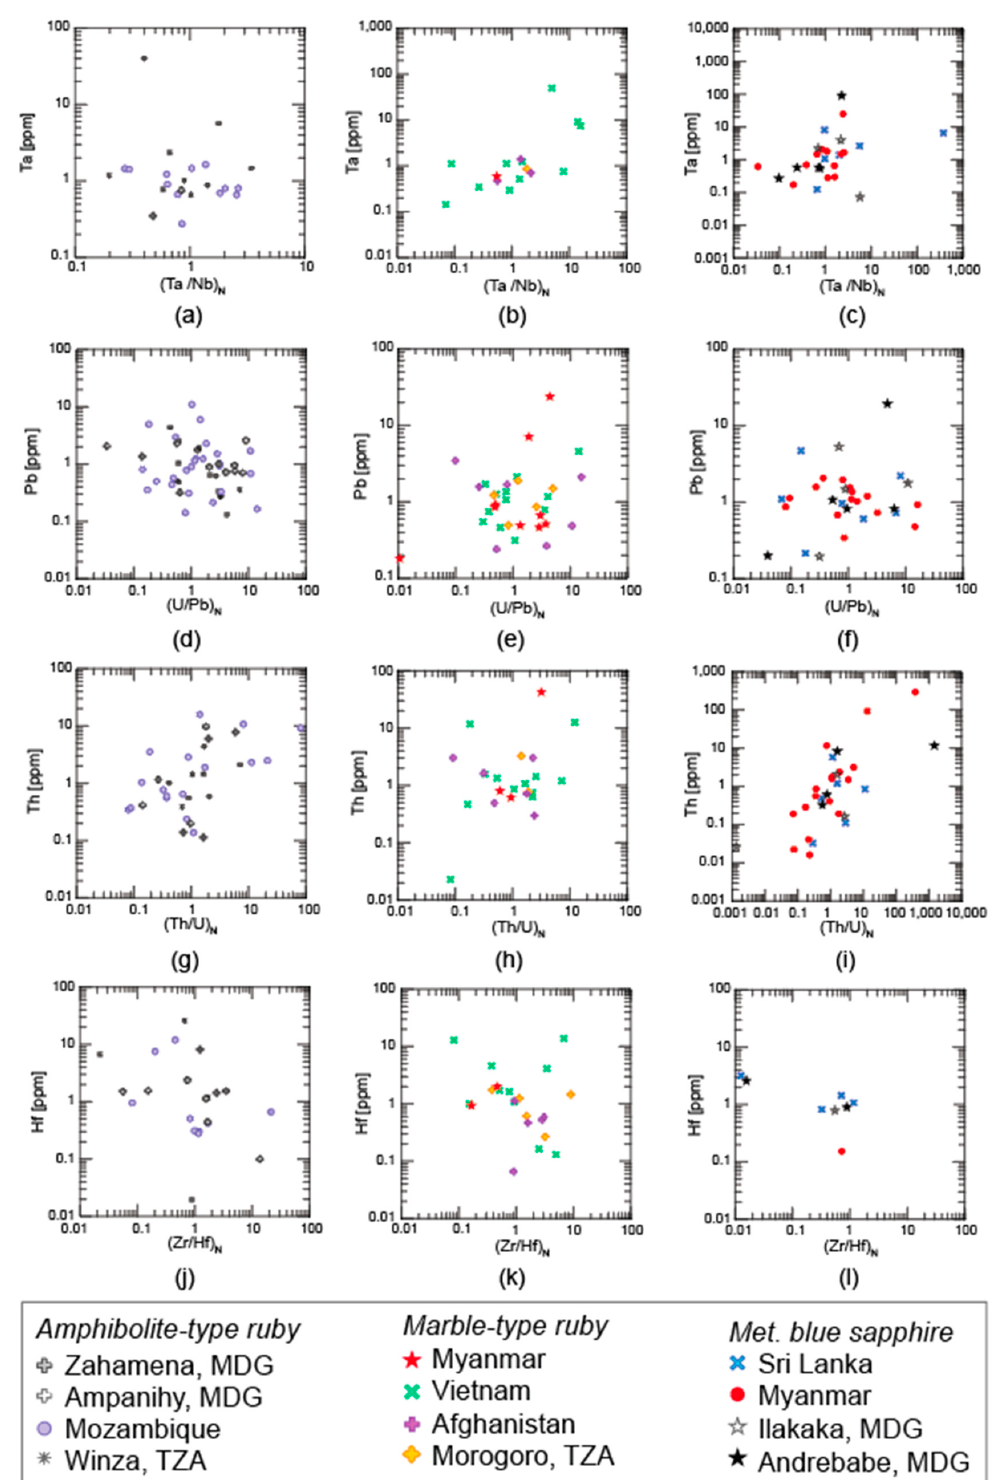
Figure A1. Primitive mantle-normalized [58] LA-ICP-MS data of gem corundum analyzed in this study. Points represent individual analyses. ( a – c ) Ta versus (Ta / Nb) N ; ( d – f ) Pb versus (U / Pb) N , ( g – i ) Th versus (Th / U) N , and ( j – l ) Hf versus (Zr / Hf) N for amphibole-type ruby, marble-type ruby, and met. blue sapphire, respectively.